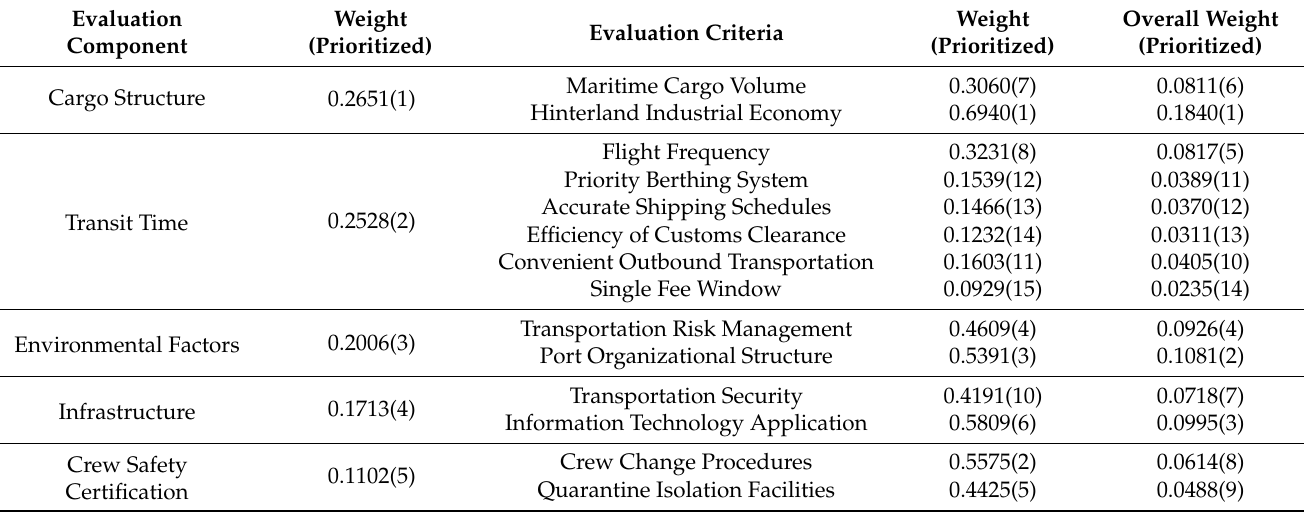
Table 4. Importance ranking of key factors influencing shipping companies and ship management companies’ choices of ports for international crew